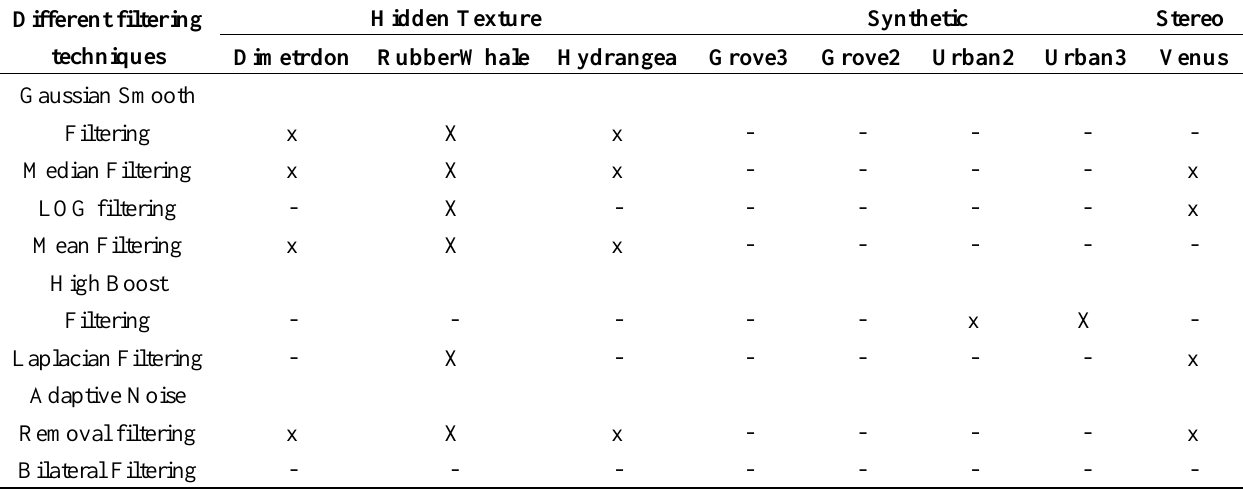
Table 2. Comparison between filtering methods at initial level and all levels on pyramidal Lucas-Kanade optical flow.